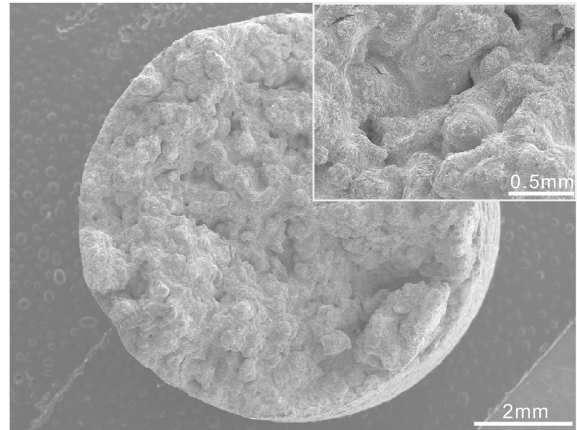
Figure 5: Fracture surface of a specimen after tension at 1050 ° C and 10 − 4 · s − 1